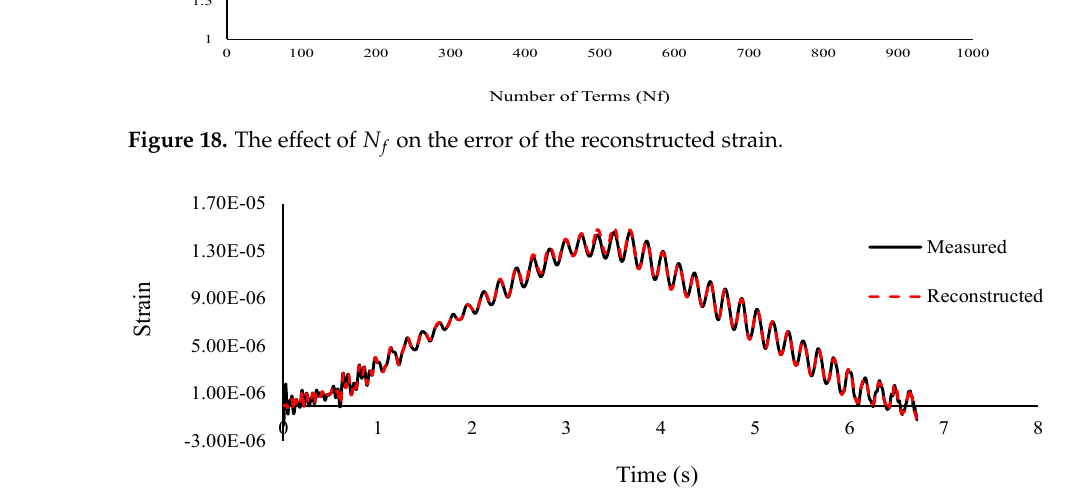
Figure 19. Measured and reconstructed strain at mid-span.